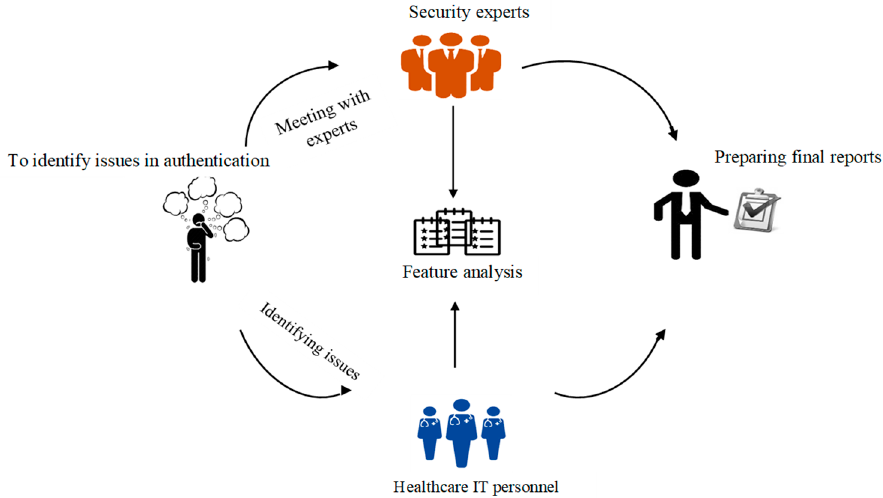
Figure 4. Case study scenario.